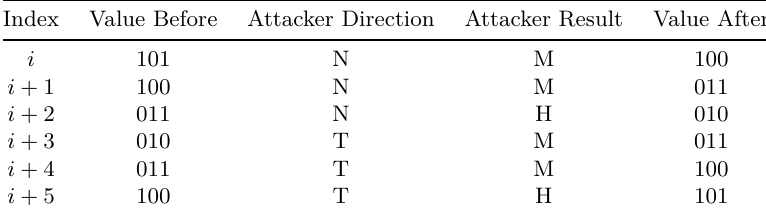
Table 4: The relationship between the attacker’s execution and the value of the target 2-level predictor entry. M – misprediction, H – hit (correct prediction), N – not taken, T – taken, Value Before (or After) – the binary value of the saturating counter before (or after) executing the target branch.